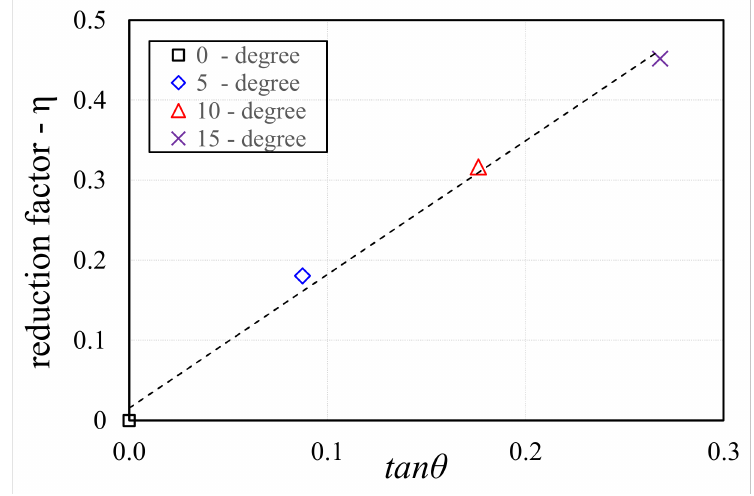
Figure 12. Relation of impact force reduction factor and tangent value of bed